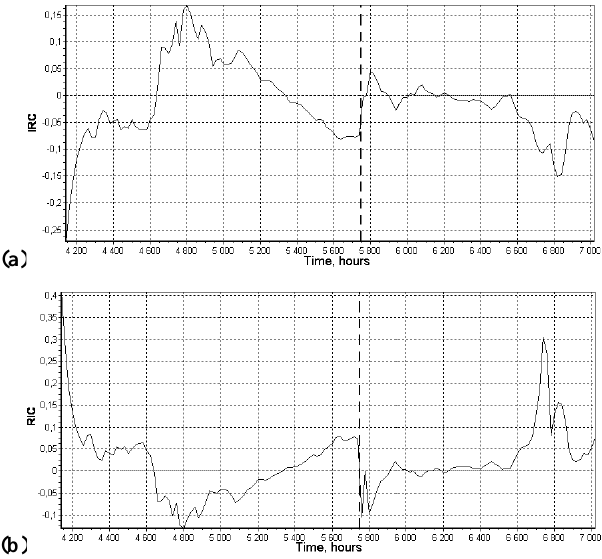
Fig. 4. The integral relative (IRC, a ) and relative integral (RIC, b ) non-stationarity criteria for sensor 3 data. IRC 1 and RIC 1 criteria are almost the same in this case (but this is not true in